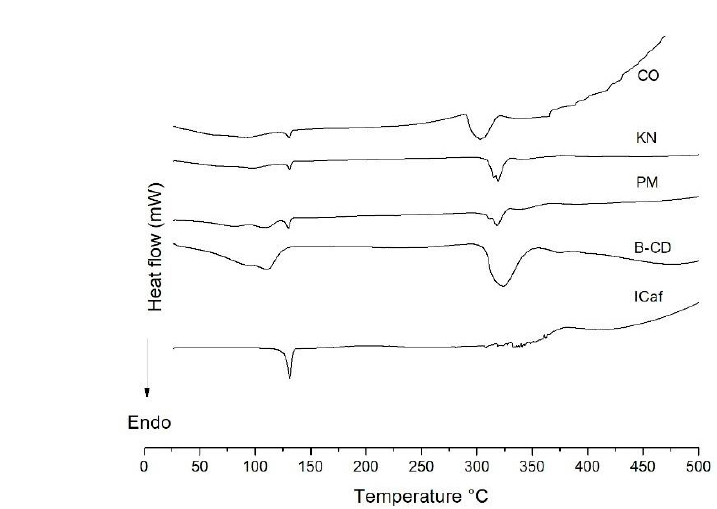
Figure 2. Differential scanning calorimetry curves of isopentyl caffeate (ICaf), β -cyclodextrin ( β -CD), and inclusion complex (ICaf: β -CD) prepared by physical mixture (PM), kneading (KN), co-evaporation (CO) using molar ratios of ( A ) 0.25:1, ( B ) 1:1 and ( C ) 2:1.